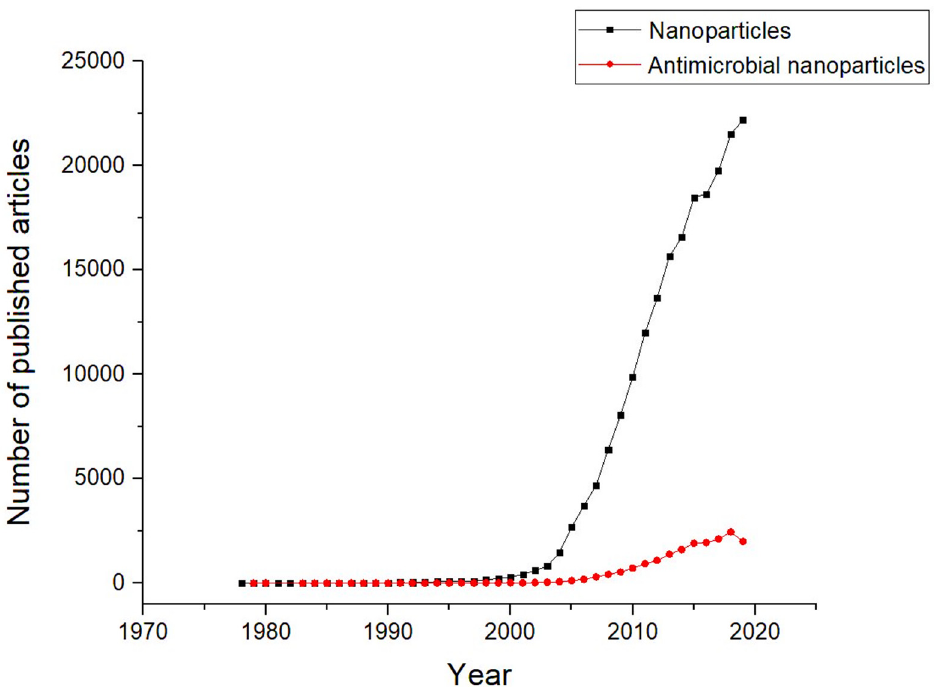
Figure 1. The graph shows articles published yearly containing keywords nanoparticles and anti- microbial nanoparticles. Data collected from PubMed.